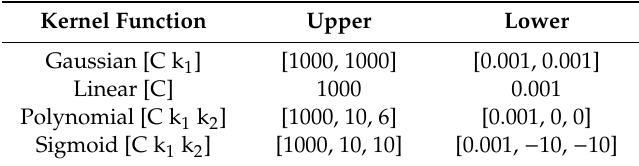
Table 4. Variable